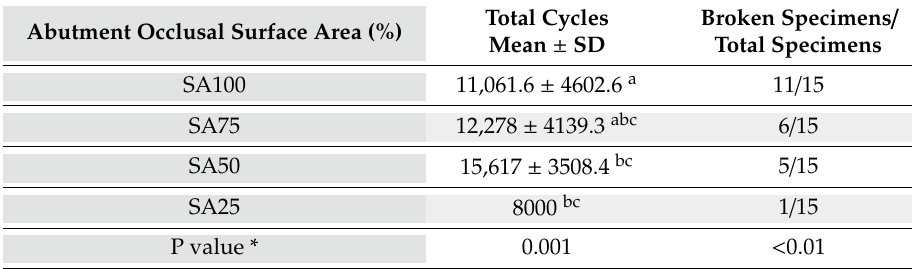
Di ff erent superscript letters in the column represented statistical significance between groups (P < 0.05; post hoc Dunn test). Total cycles indicated total number of cycles ran before specimens broke under 300 N loading or 30,000 cycles if specimens remained intact. SD: Standard deviation. a, b, c are notations depicting di ff erent class variations. * Krukal-Wallis test (K independent